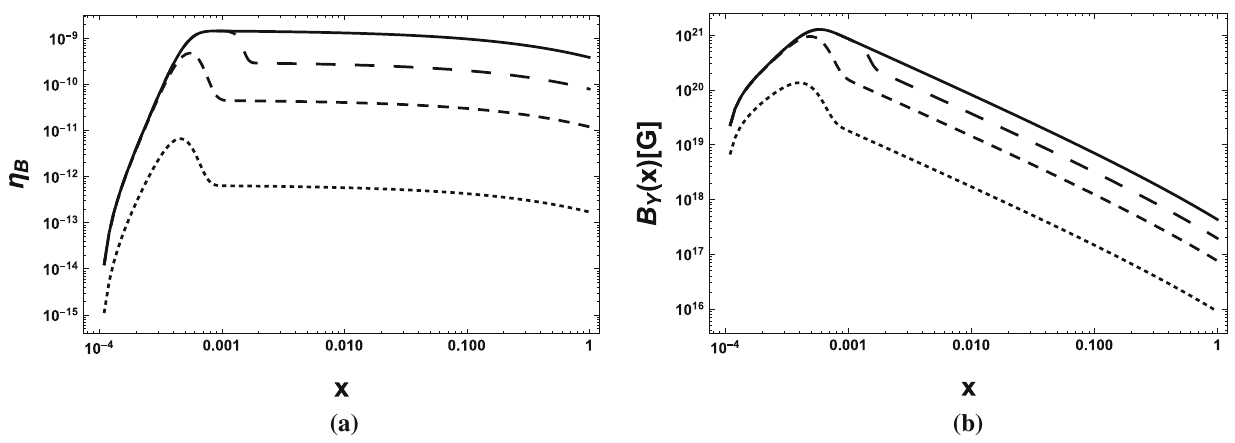
Fig. 5 Timeplotsof: a thebaryonasymmetry η B , b thehypermagnetic field amplitude B Y for two sets of successive and opposing fluctuations. The initial conditions are: k = 10 − 7 , B v = v = 10 − 5 , b = 2 × 10 − 4 , β 0 , + 0 , −